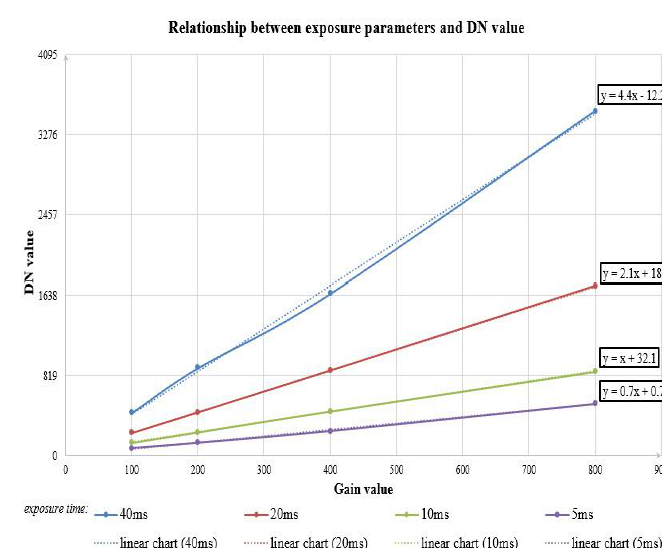
Figure 4. The relationship between the DN value and exposure